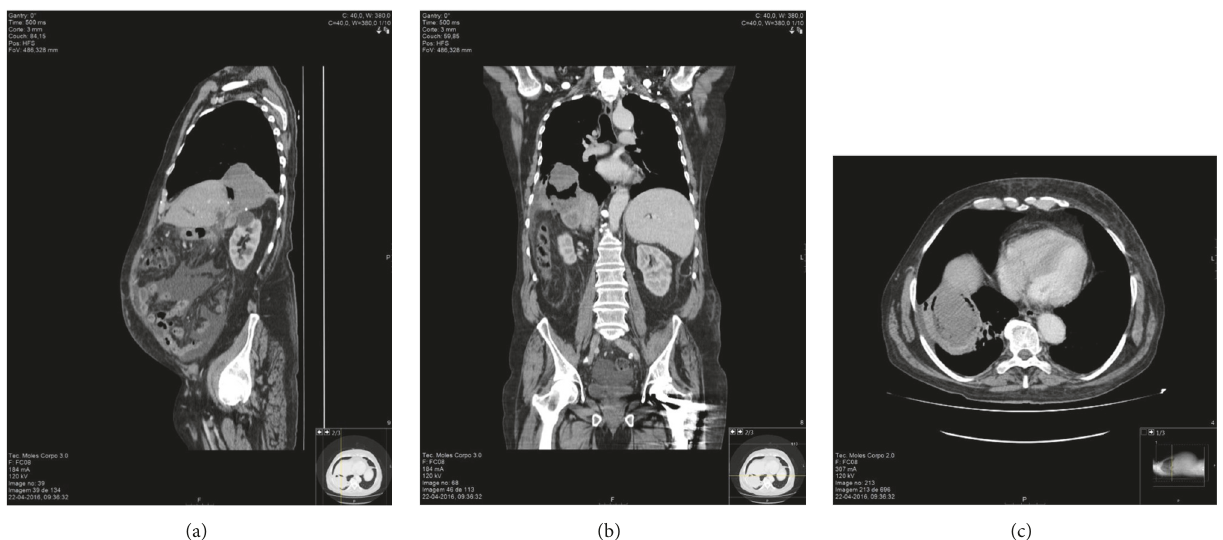
Figure 1: CT-Scan performed in April 2016: (a) sagittal plane, (b) coronal plane, and (c) transverse